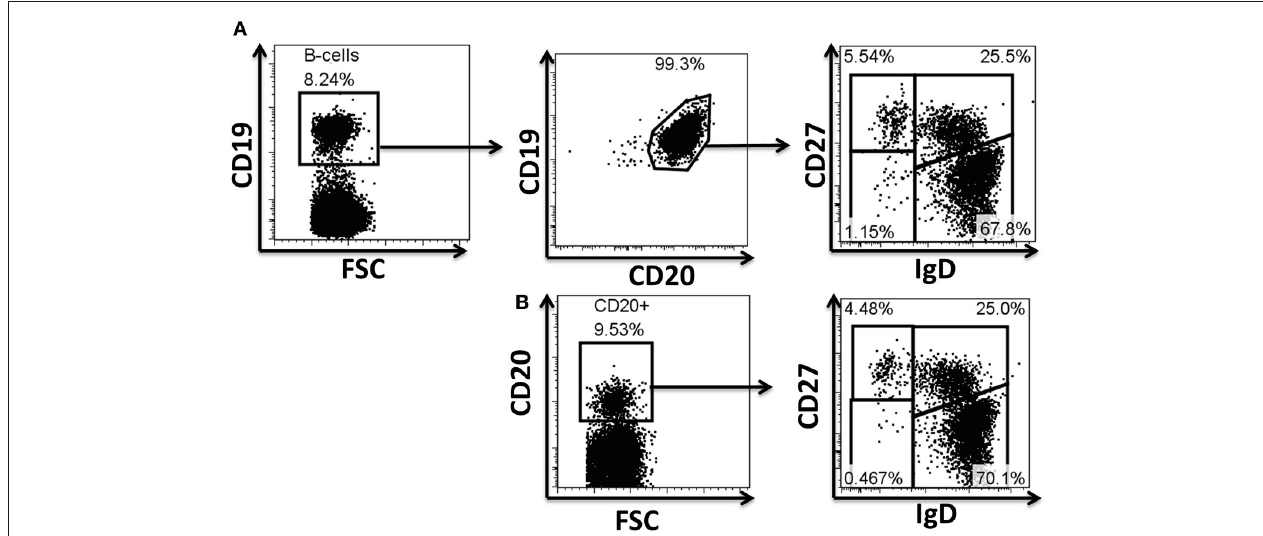
FIGURE A1 | Evaluation of antibodies for phosphoflow in naïve and B M cell subpopulations. Example of surface staining for identification of B cells and their subpopulations. CD19 and CD20 are typically used to define B cell populations (A) . Several monoclonal antibodies were evaluated to define B cells, as well as naïve and memory B cell subpopulations during the optimization of the staining technique for phosphoflow. The CD19 marker is